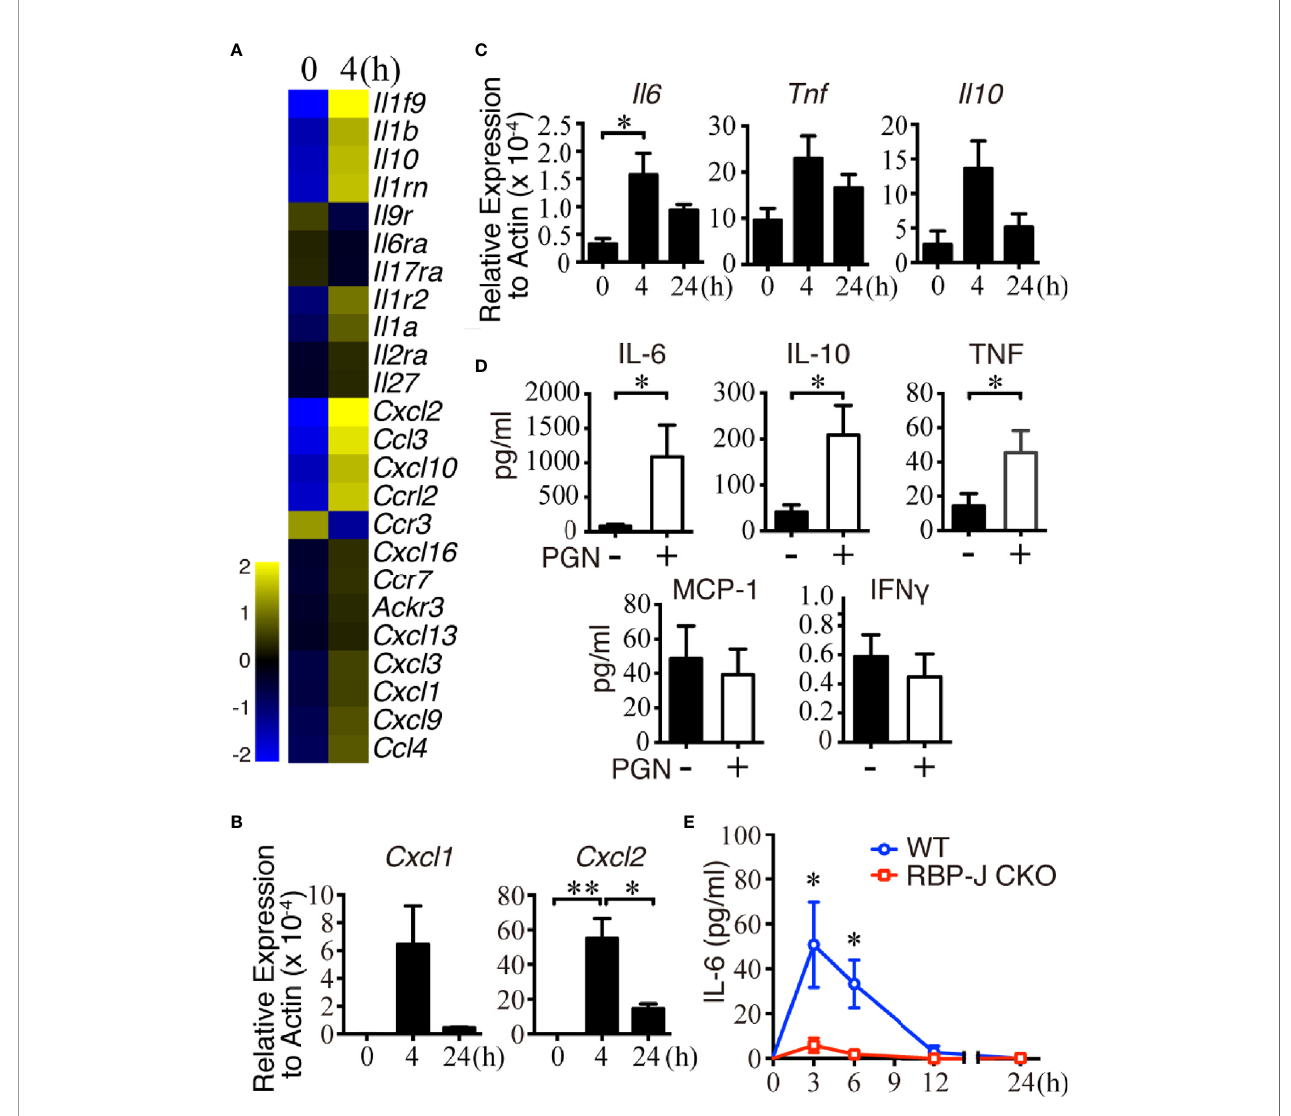
FIGURE 2 | Changes of cytokine and chemokine expression in MZ B cells in the early stage of S. aureus infection. (A) Changes in the expression of chemokine- and cytokine-related genes in MZ B cells isolated from mice after infection with S. aureus (2.5 × 10 6 CFU) by iv injection, as revealed by a cDNA microarray analysis. Heatmap showing the expression of several chemokine- and cytokine-related genes in MZ B cells. (B) RT-qPCR analysis of the Cxcl1/Cxcl2 mRNA levels in MZ B cells isolated 0, 4, or 24 h after S. aureus infection. Results were normalized to the actin mRNA levels. (C) RT-qPCR analysis of the Il6, Il10 , and Tnf mRNA levels in MZ B cells isolated 0, 4, or 24 h after S. aureus infection. Results were normalized to the actin mRNA levels. (D) Cytokines produced by puri fi ed MZ B cells treated with or without PGN (2 µg/ml) for 24 h were determined by a Cytometric Bead Array. (E) ELISA showing the levels of IL-6 in the splenic tissue homogenates of RBP- J CKO and WT mice at 0, 3, 6, 12, and 24 h after S. aureus infection (2.5 × 10 6 CFU). Statistical analysis was conducted by performing an unpaired t -test (C, E) and one-way ANOVA (B, D) . Data are presented as the mean ± SEM (n = 3 in B, n = 6 – 7 in C, n = 3 – 6 in D, and n = 6 in E). * p < 0.05 and ** p <